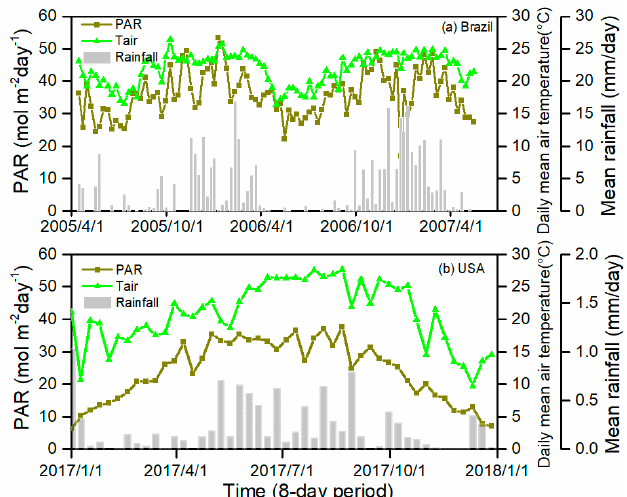
Figure 2. The seasonal variation in the daily mean air temperature ( o C), rainfall, and photosynthetically active radiation (PAR) at the two sugarcane EC tower sites (8-day interval). ( a ) Brazil site, 2005–2007; ( b ) Louisiana site, USA, 2017.